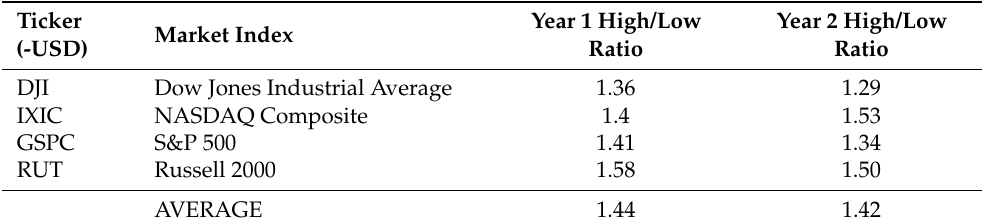
Table 5. Major market indices high/low